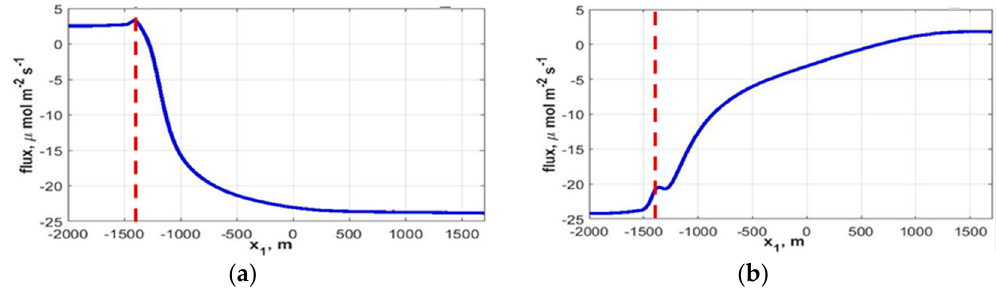
Figure 2. Vertical CO 2 fluxes at the height of 30 m above the ground surface (forest height is 15 m, LAI = 5 m 2 m -2 ). The air flow moves from open area to the land surface covered by forest ( a ) and from the forested to open area ( b ) respectively. The dotted line shows the vegetation